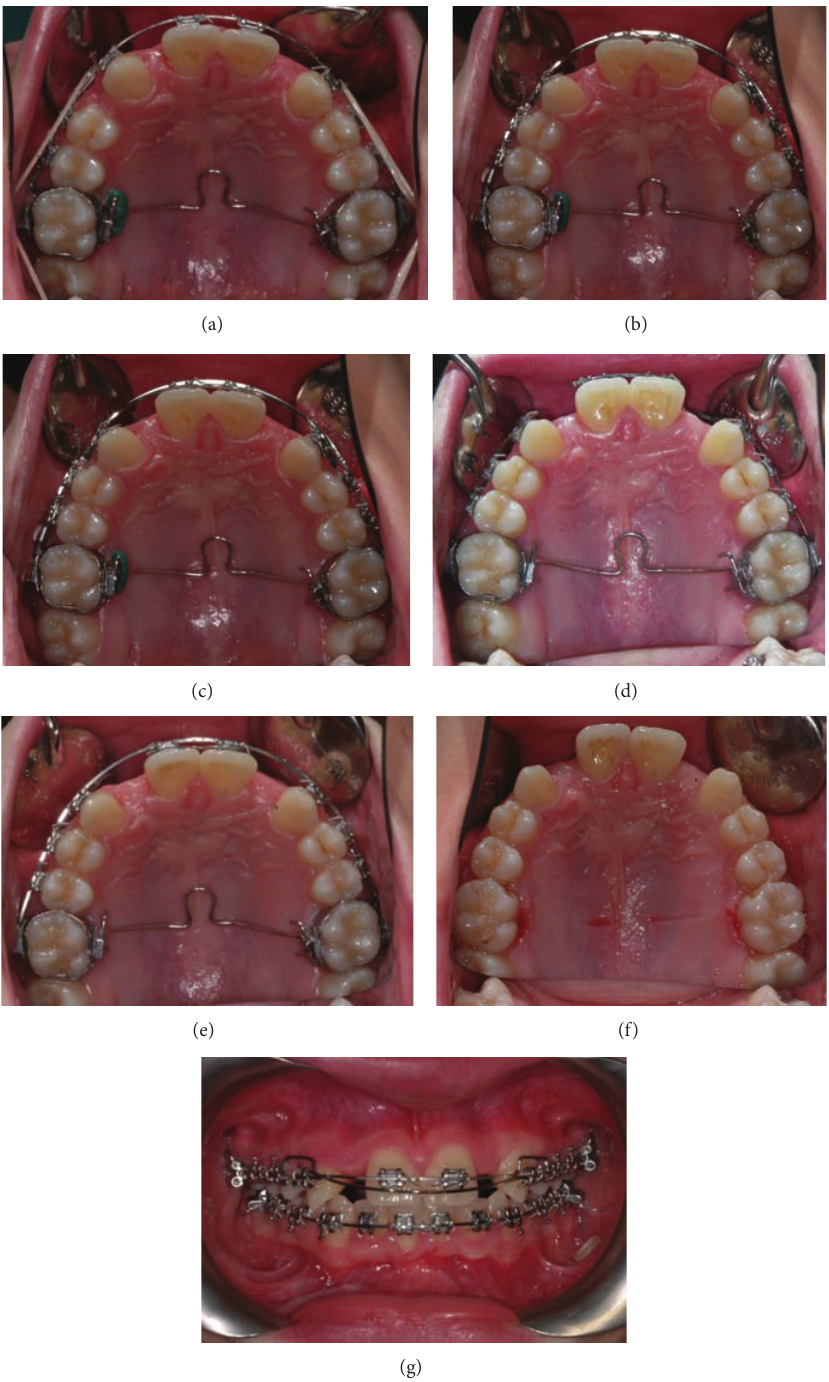
Figure4: Progressivespaceopening forthemaxillary lateral incisors((a)–(f)).Thedistopalatal rotationsof thecanines were furthercorrected by using a .019 󸀠󸀠 × .025 󸀠󸀠 TMA sectional determining Burstone’s 6th Geometry